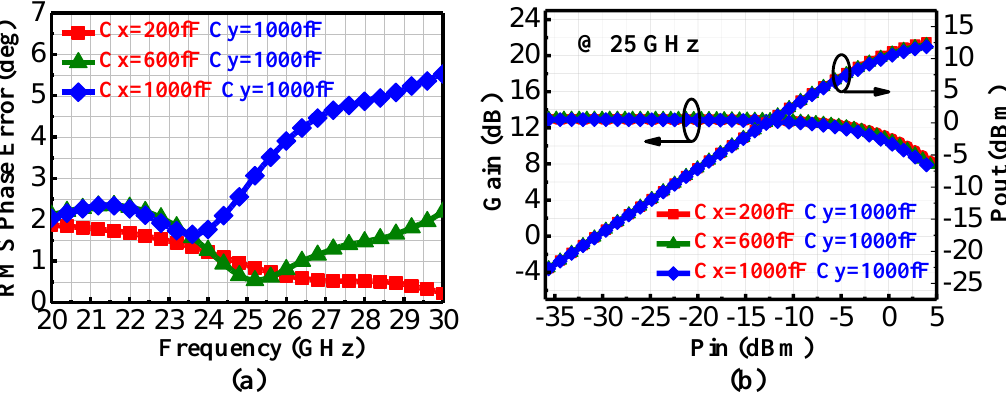
Figure 11. ( a ) Measured RMS phase errors versus frequency at different control modes; ( b ) measured large signal performance of the VGA at 25 GHz.